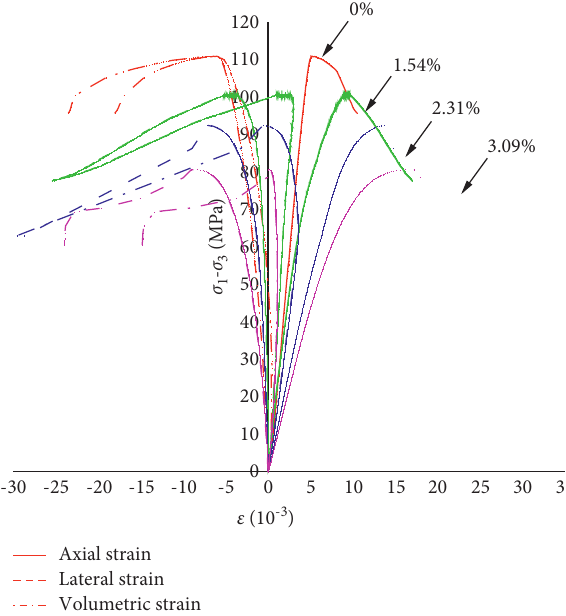
4: Total stress-strain curve under the confining pressure of 45MPa with different water contents.